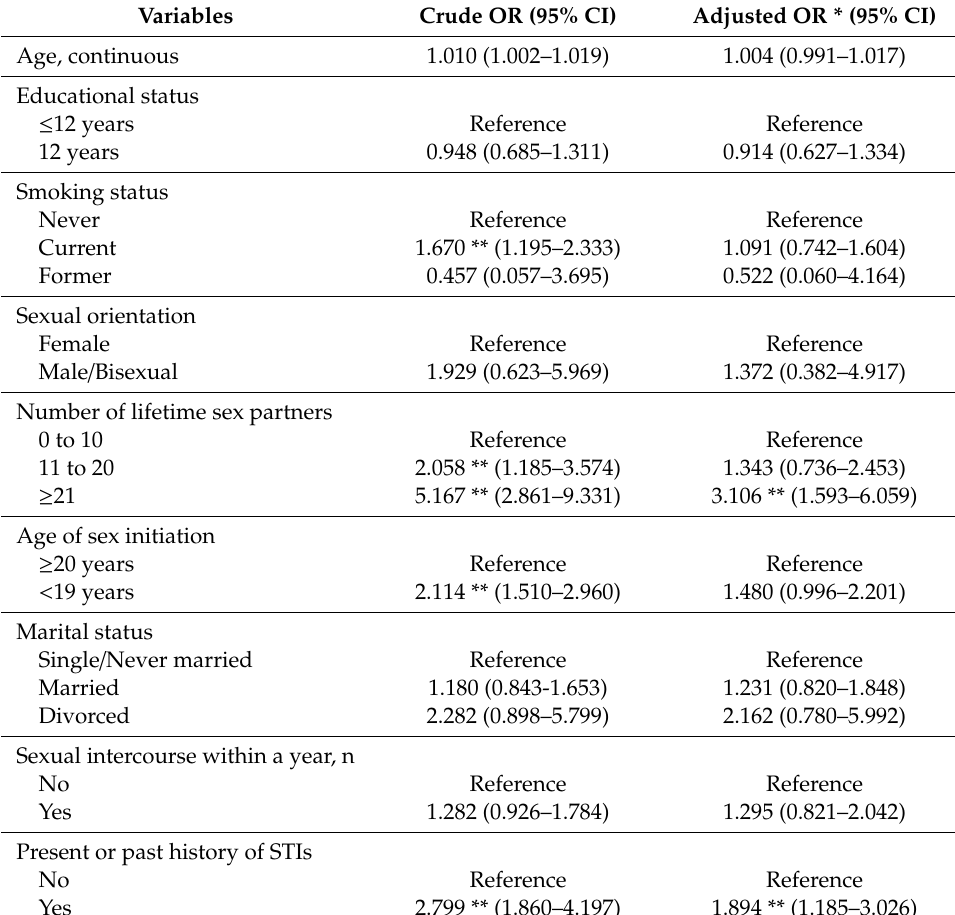
Figure 2. The detection rate among 9v HPVs: Type 52 was the most detected genotype (n = 40; 40 / 99; 40.4%). Table 3. Predictors against any HPV infection.